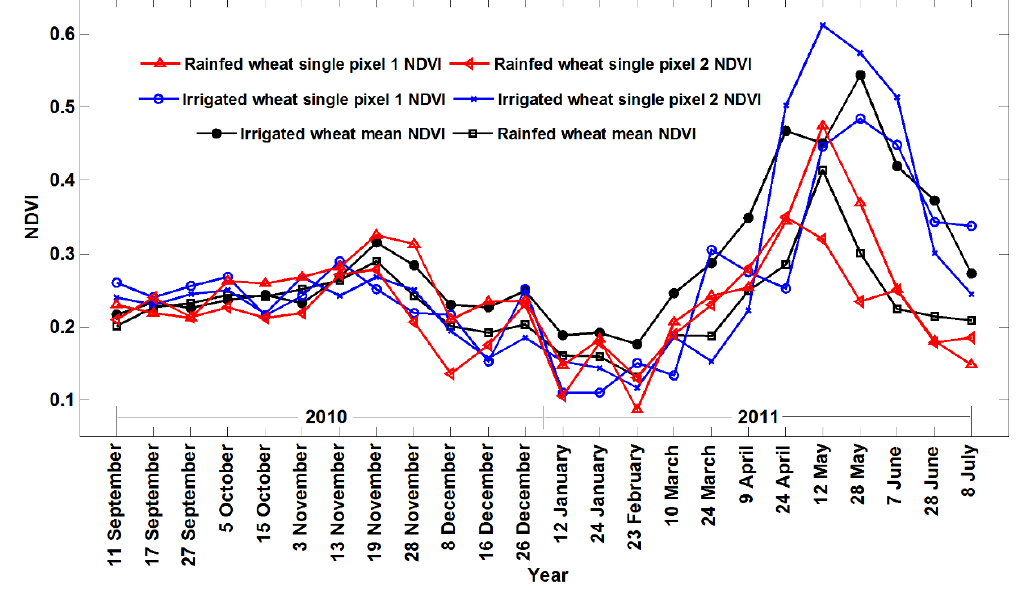
Figure 3. NDVI temporal variations for major land cover types in the south central Shanxi Province.